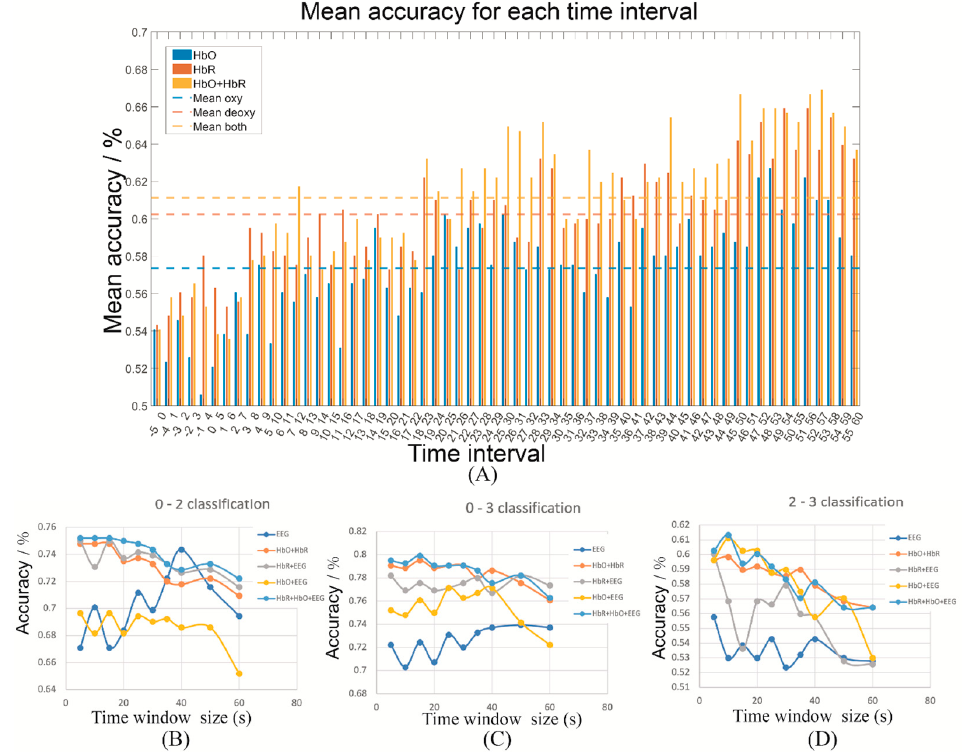
Figure 3. Time window analysis ( A ) Time interval analysis for fNIRS features; Time window ‐ size evaluation for EEG and fNIRS features for ( B ) 0 ‐ back vs. 2 ‐ back, ( C ) 0 ‐ back vs. 3 ‐ back, ( D ) 2 ‐ back vs. 3 ‐ back.